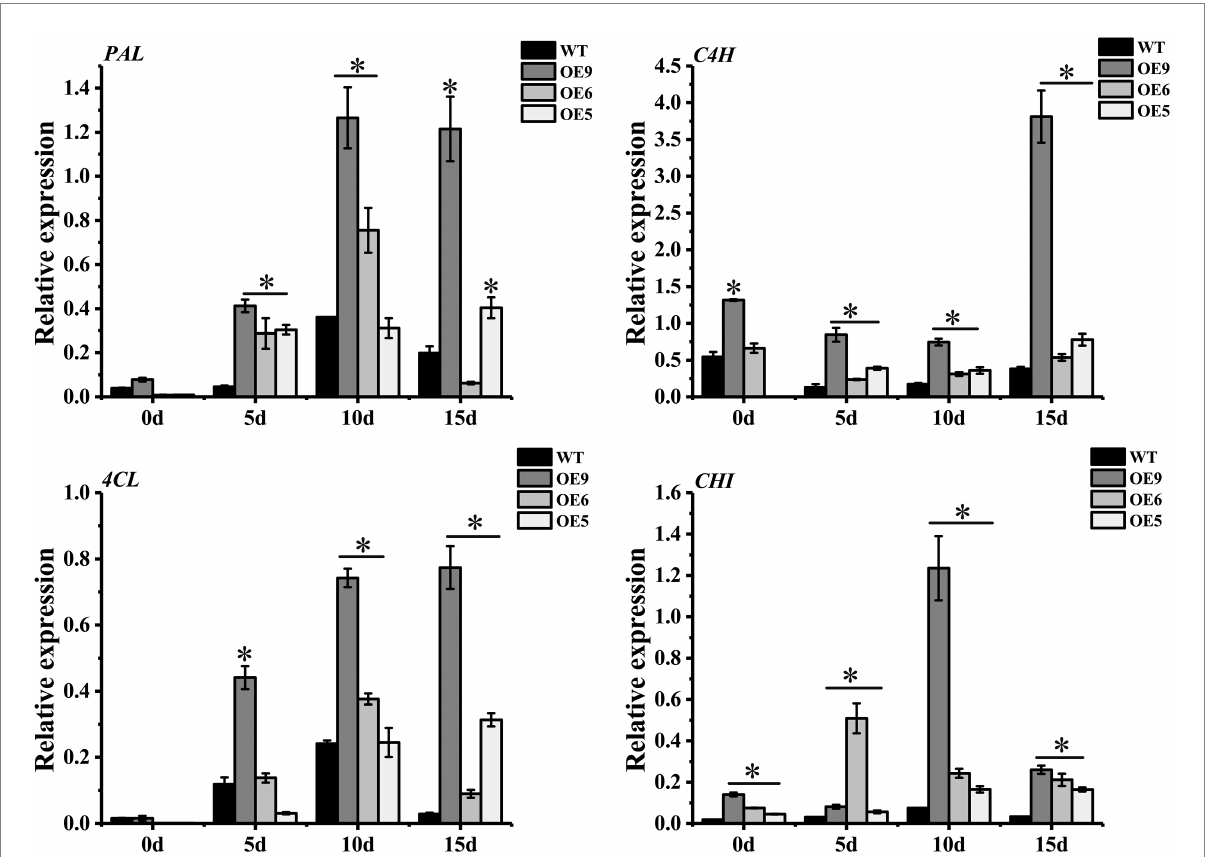
FIGURE 6 Quantitative qRT-PCR analysis of different gene expressions in WT and OE lines. PAL , C4H , 4CL and CHI represent genes of phenylalanine ammonia-lyase, cinnamate-4-hydroxylase, 4-coumarate coenzyme A ligase and chalcone isomerase, respectively. Actin was used as an internal standard for the analysis. * represent the significant differences of three replicates as determined by SPSS software ( p < 0.05).